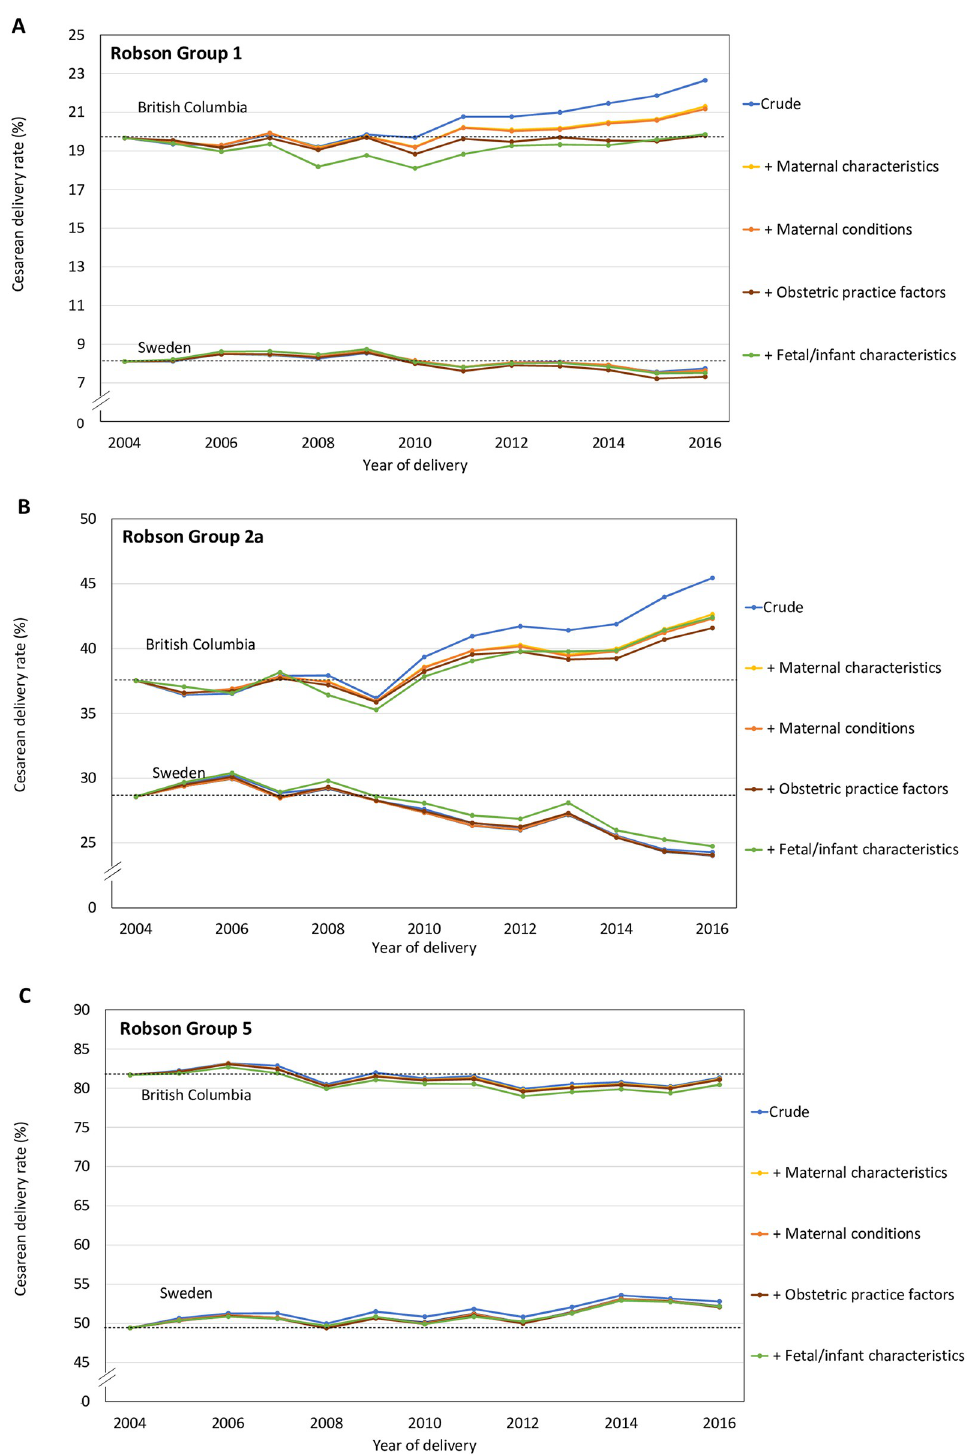
Fig 4. Observed rates of CD and rates adjusted sequentially for changes in maternal characteristics, maternal conditions, obstetric practice, and fetal/infant characteristics among women in Robson Group 1 (panel A), Robson Group 2a (panel B), and Robson Group 5 (panel C) in Sweden and BC, Canada, 2004–2016. Note that the y axis scales differ for the presentations of Robson Groups 1, 2a, and 5. BC, British Columbia; CD, cesarean delivery.